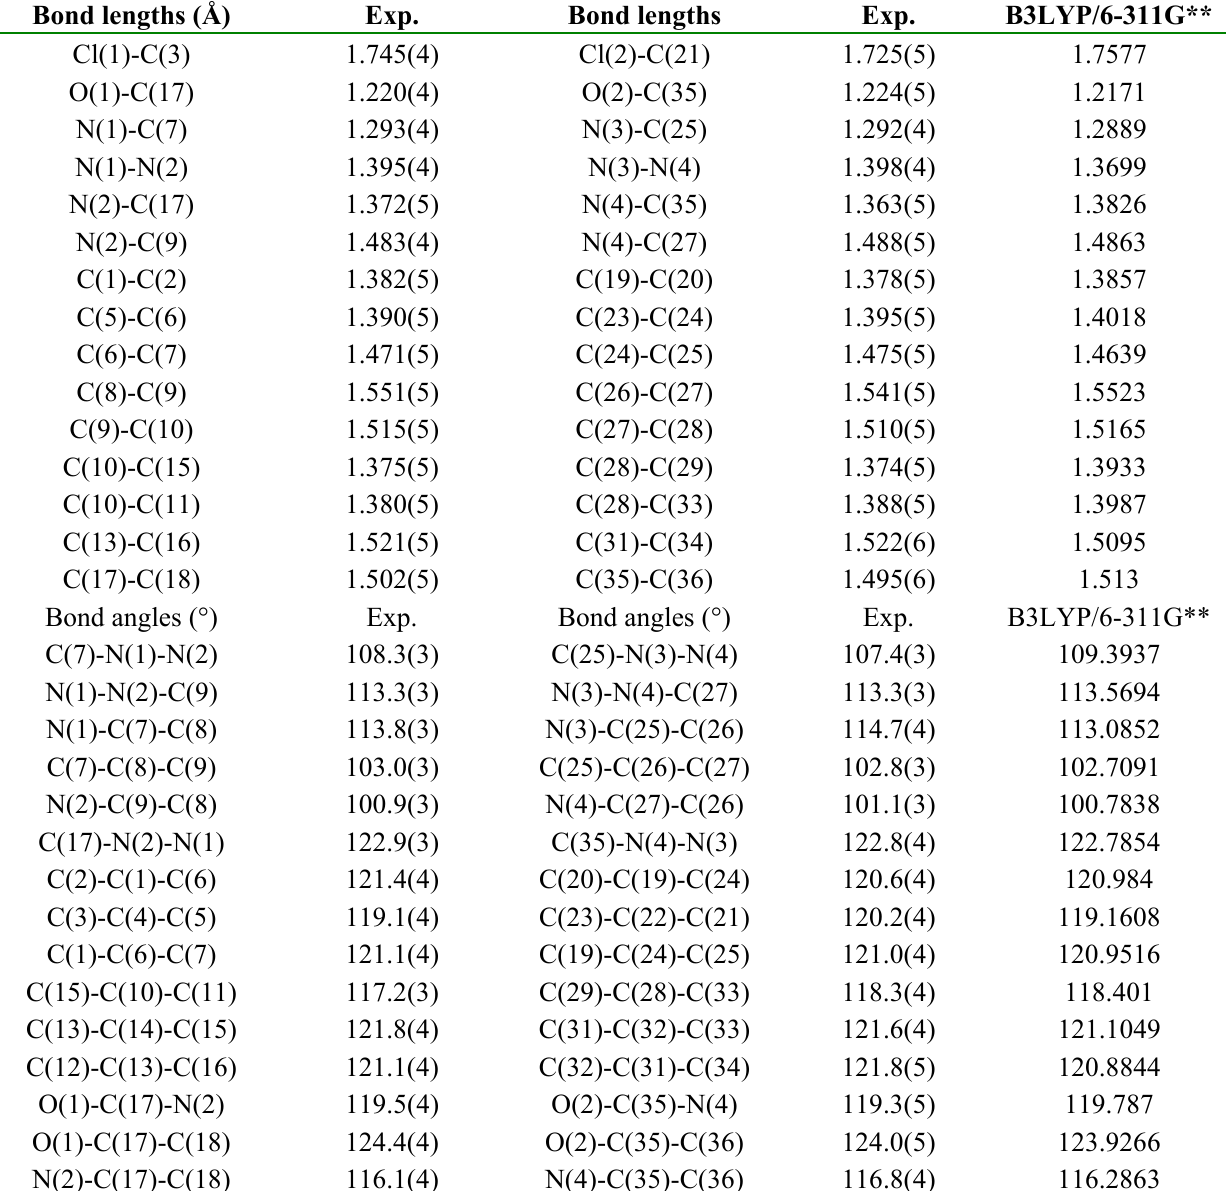
Table 1 . Selected structural parameters by X-ray and theoretical